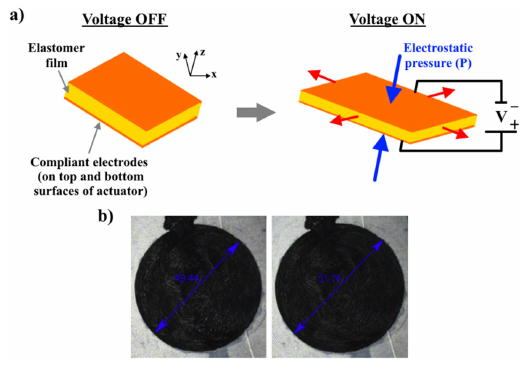
Figure 3. ( a ) Work principle of the DE actuator and ( b ) actuation of 3D printed DE actuator (U = 4.67 kV). Reprinted/adapted with permission from Ref. [16]. 2019, Elsevier. The power of the DE actuators depends on the electrostatic pressure, which is deter ‐ mined by Equation (1). The magnitude of the generated electrostatic pressure (P)